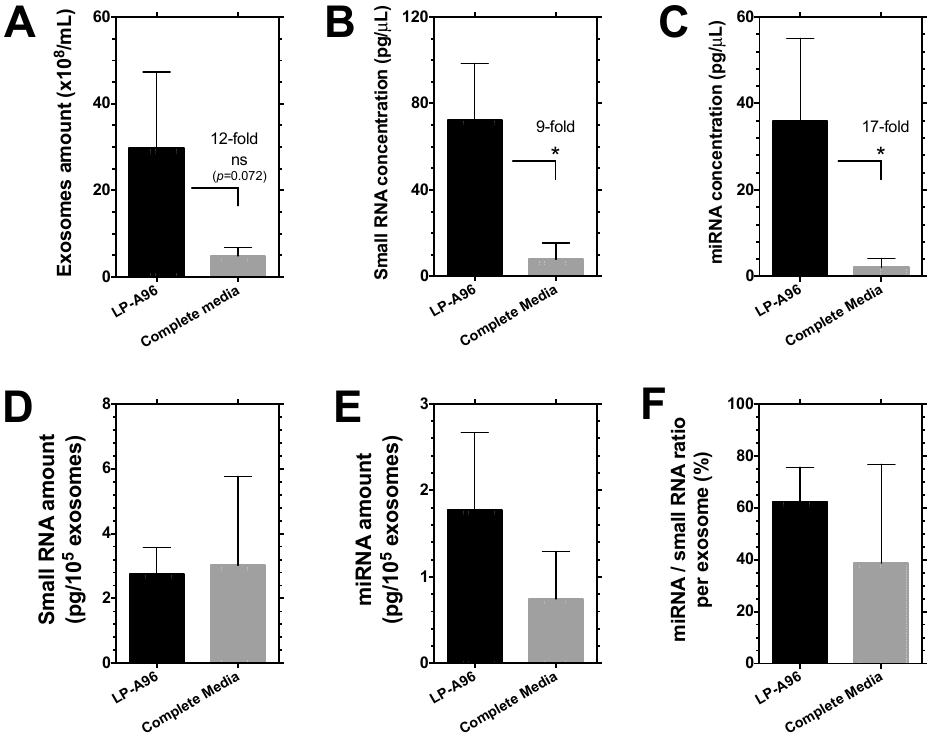
Figure 4. LP-A96 induced exosomes are properly loaded with RNAs. ( A ) Exosomes purified from subconfluent HCE-T cells after 36 h of incubation with either 1 µ M LP-A96 in basal media or complete media shows stimulated exosome biogenesis and release by LP-A96 treatment. These exosomes were subjected to RNA isolation. ( B , C ) Elevated small RNA (0~270 nucleotides) and miRNA (10~40 nucleotides) amount reflects an increase in total exosome amount shown in ( A ). ( D ) Small RNAs, ( E ) miRNAs, and ( F ) miRNA-to-small RNA ratio per exosome particle under two di ff erent treatment conditions are similar. n = 3. Mean ± SD. * p < 0.05, ns: non-significant.